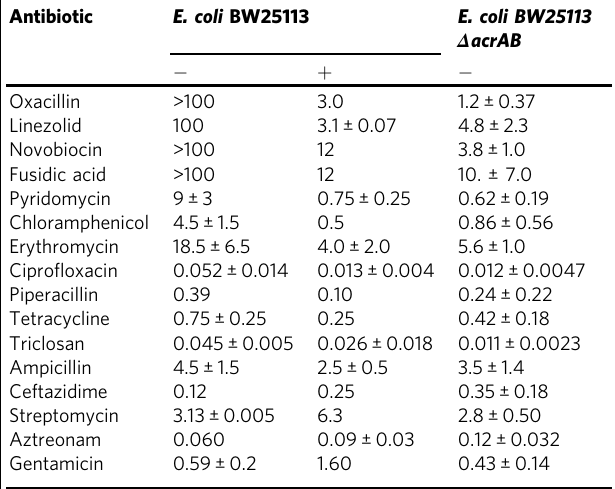
As a comparison, the antibiotic susceptibility of E. coli lacking acrAB is also indicated. BDM88855.HCl ( 9 ’ ) on its own has no impact on E. coli growth up to the highest concentration tested (250 µ M). Data are the mean±SEM of least two independent biological replicates (SEM is not indicated when all replicates showed the same MIC). Source data are provided as a Source Data fi le.